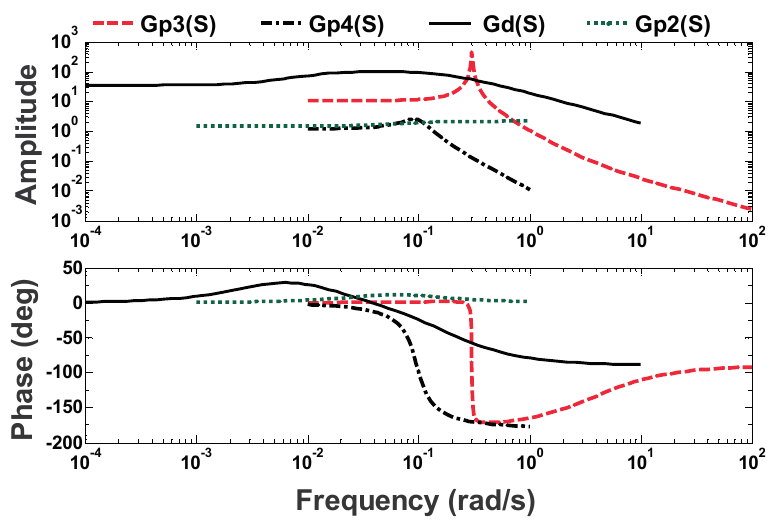
Figure 3. Phase diagram (frequency response) of process